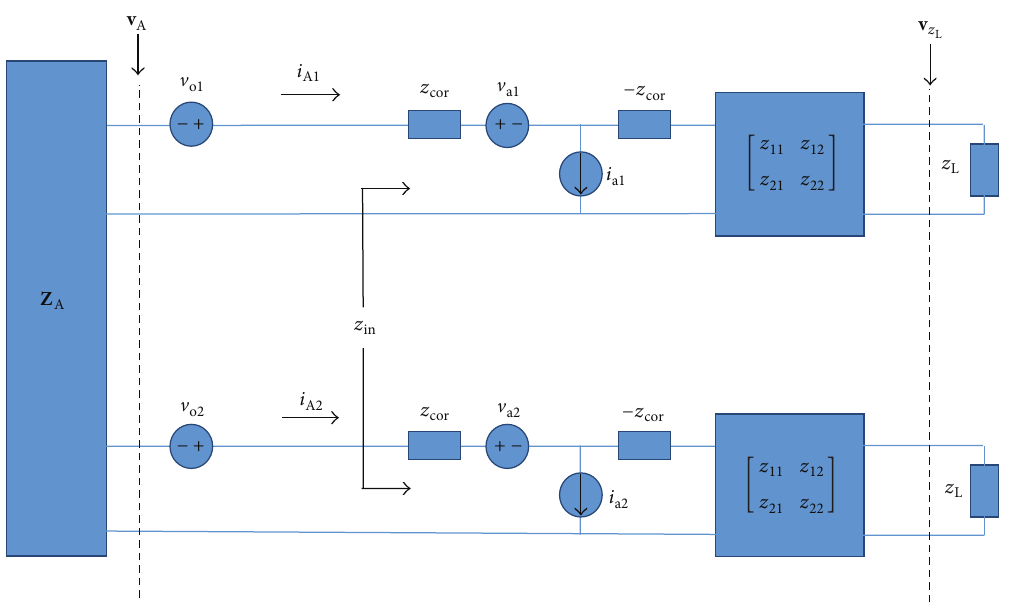
Figure 5: Network model for the receive MEA with suboptimal loading.